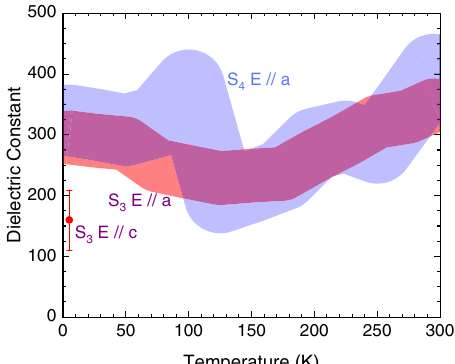
Fig. 3 Temperature dependence of the dielectric constant ( ε ). ϵ in units of ϵ 0 vs temperature for two samples from batch S 4 ( n SdH =